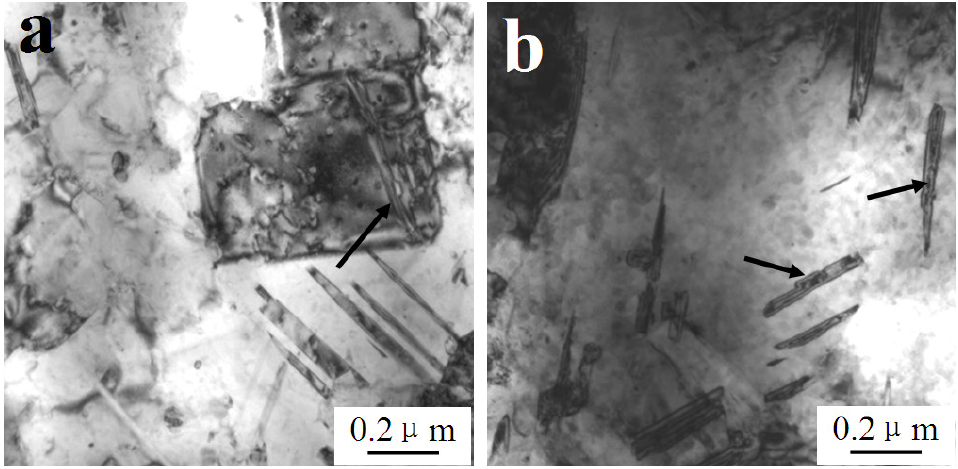
Figure 6. Annealing twins in the matrix of W f /Cu 82 Al 10 Fe 4 Ni 4 composites: ( a ) annealing twins in recrystallized grains and ( b ) annealing twins in the matrix.